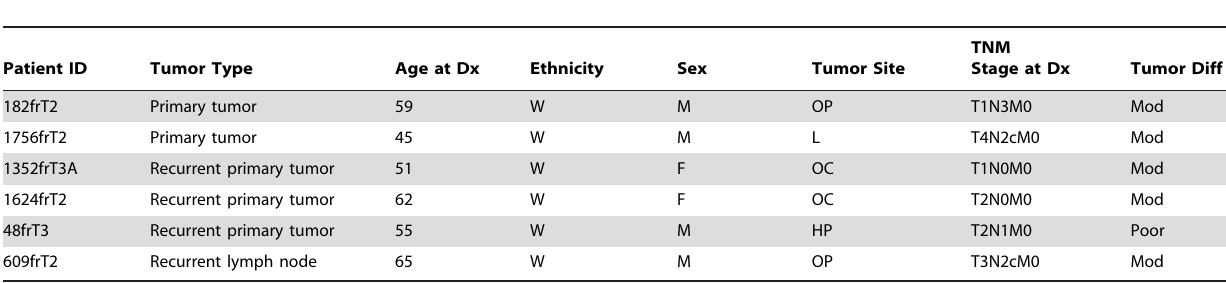
Table 2. Tumor characteristics from patients with head and neck squamous cell carcinoma.